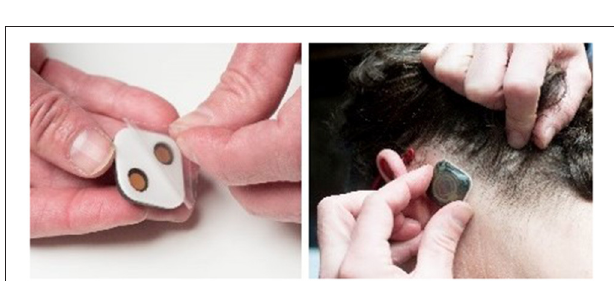
FIGURE 2 | Epilog uses one-piece disposable “stickers,” that are both the adhesive and conductive hydrogel that serve as the interface between Epilog and the scalp when used below